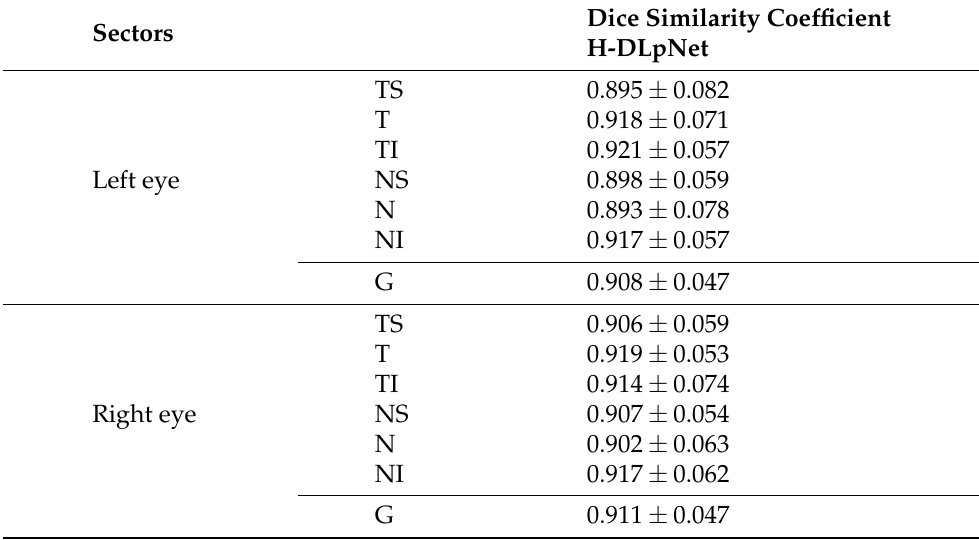
Table 6. Dice similarity coefficient (mean and standard deviation) calculated comparing the results of the proposed method and the H-DLpNet method for each sector of the eye and for the whole